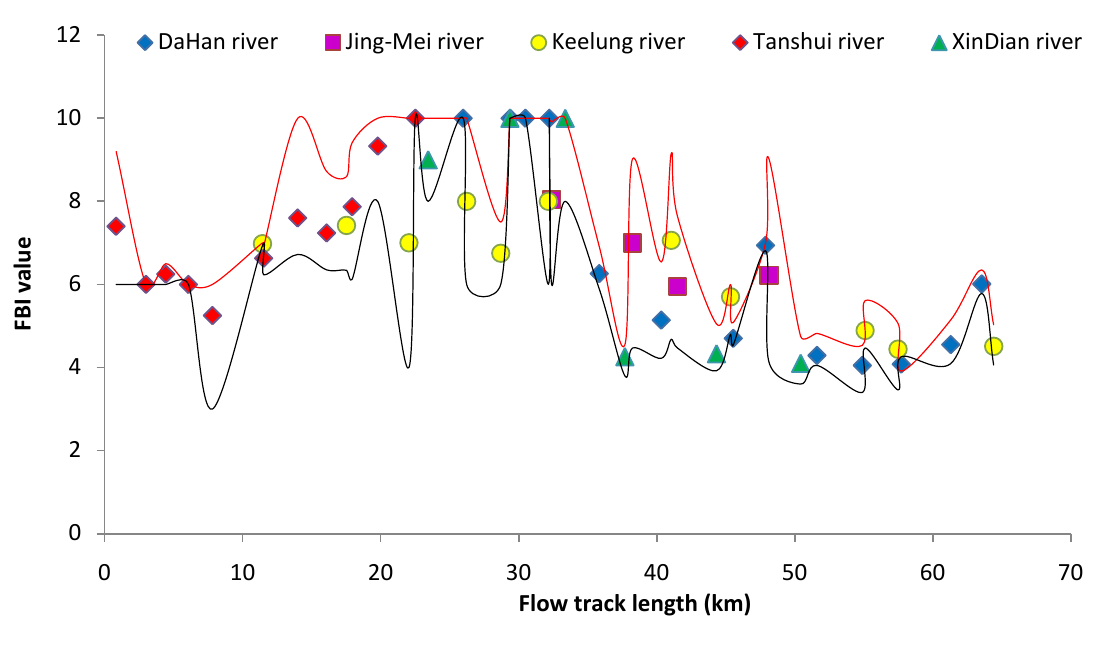
Figure 6. The FBI value for the benthic macroinvertebrate community of the Tanshui River basin in 2012. The point marks indicate the mean of four seasons, red line was upper limit and black line was lower limit.